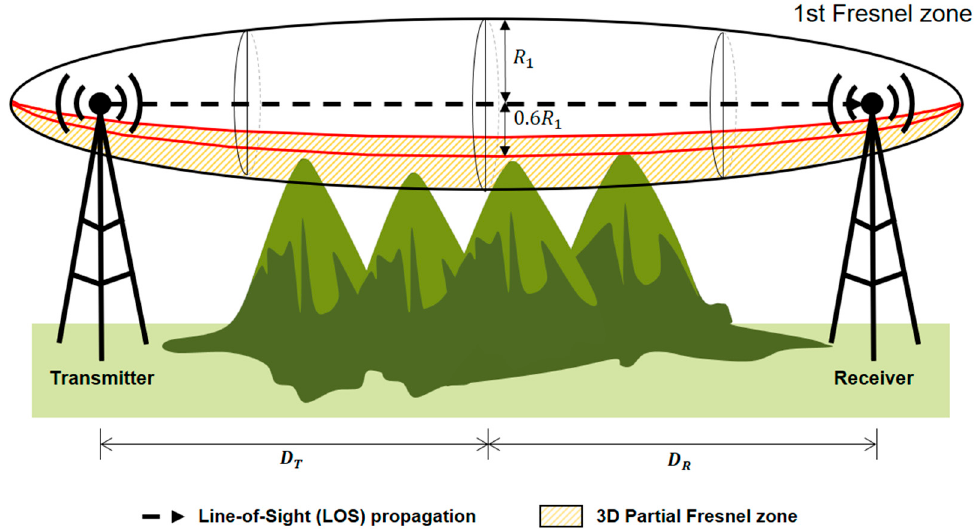
Figure 1. Conceptual view of the first Fresnel zone and the 3D Partial Fresnel zone.